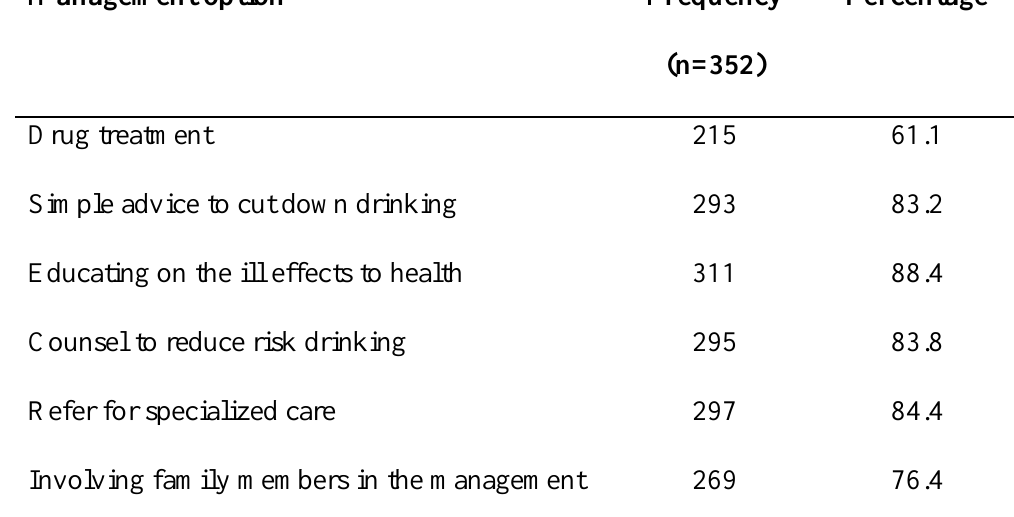
Table2-Distribution of the awareness of the study population on the available management options that can be used to reduce alcohol misuse Management